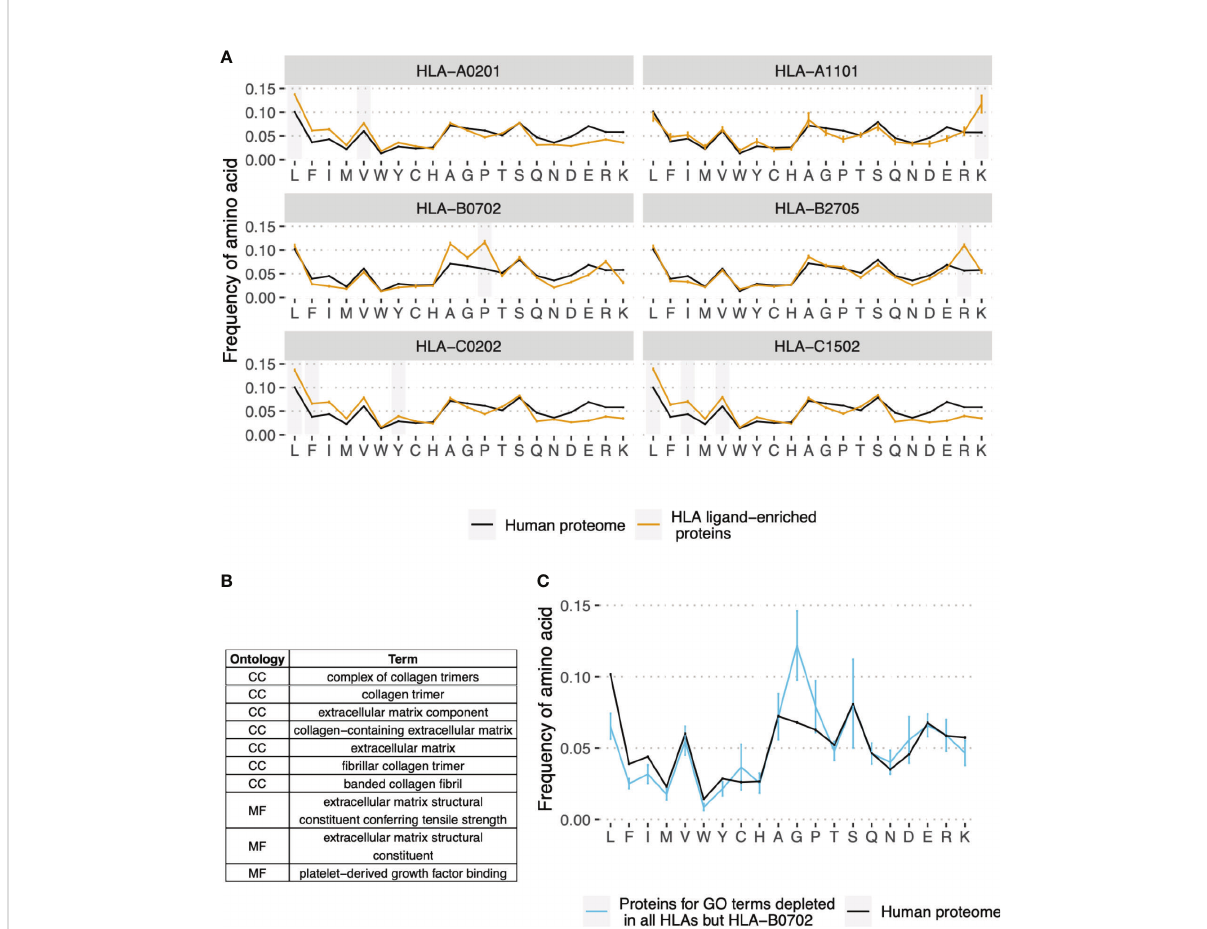
FIGURE 3 Amino acid composition of HLEPs and HLDPs for different HLA alleles. (A) Comparison of amino acid composition of HLEPs for the 6 selected HLA alleles and all proteins of the human proteome. Grey bars mark amino acids preferred by the allele in the anchor positions (P2 and/or P9) according to Supplementary Figure 1. Note that HLEPs tend to have a higher frequency of amino acids that are good anchors for this allele. Error bars show 95% con fi dence interval for the mean value. (B) GO categories associated with HLDPs for 5 of 6 selected alleles (all but HLA- B*07:02). Ontology names: CC - cellular component, MF - molecular function, BP - biological process. (C) Comparison of amino acid composition of proteins corresponding to GO categories from (B) (only proteins which are in HLDPs for at least 1 allele were considered) and human proteome. Error bars show 95% con fi dence intervals for the mean value. Amino acids which are enriched in proteins corresponding to “ commonly depleted ” GO categories are glycine which can ’ t be used as anchors for most HLA alleles, and proline which dramatically affect peptide backbone conformation. HLA-B*07:02 represents a special case as this allele strictly prefers proline as anchor residue in